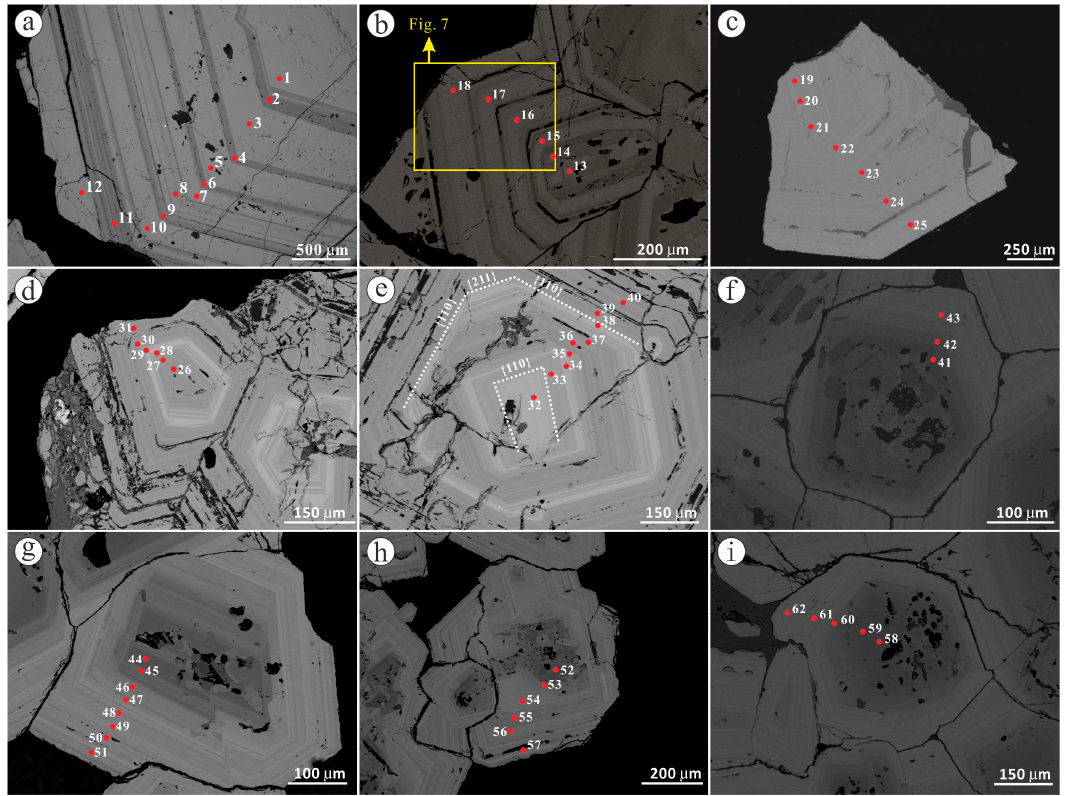
Figure 6. BSE images showing representative textural features of the Yongping garnets. ( a ) and ( b ) Dark red garnet with relatively coarse oscillatory zones that present an alternating appearance between the zones, with two different color intensities from core to rim; ( c , d ) Green garnet with extremely fine oscillatory garnet zones; ( e ) Green garnet particle with extremely fine oscillatory garnet zones, and a morphological transition from simple dodecahedral {110} growth in the core to composite dodecahedral {110}–trapezohedral {211} growth is observed near its margin in the rim. ( f – i ) Light brown garnet cores are dark gray and have no oscillatory zones, whereas the rims are gray and have extremely fine oscillatory zones. The red spots indicate the spot locations for EPMA and/or LA-ICP-MS analysis and the nearby numbers indicate the spot No. The yellow rectangular frame represents the area for EPMA mapping.